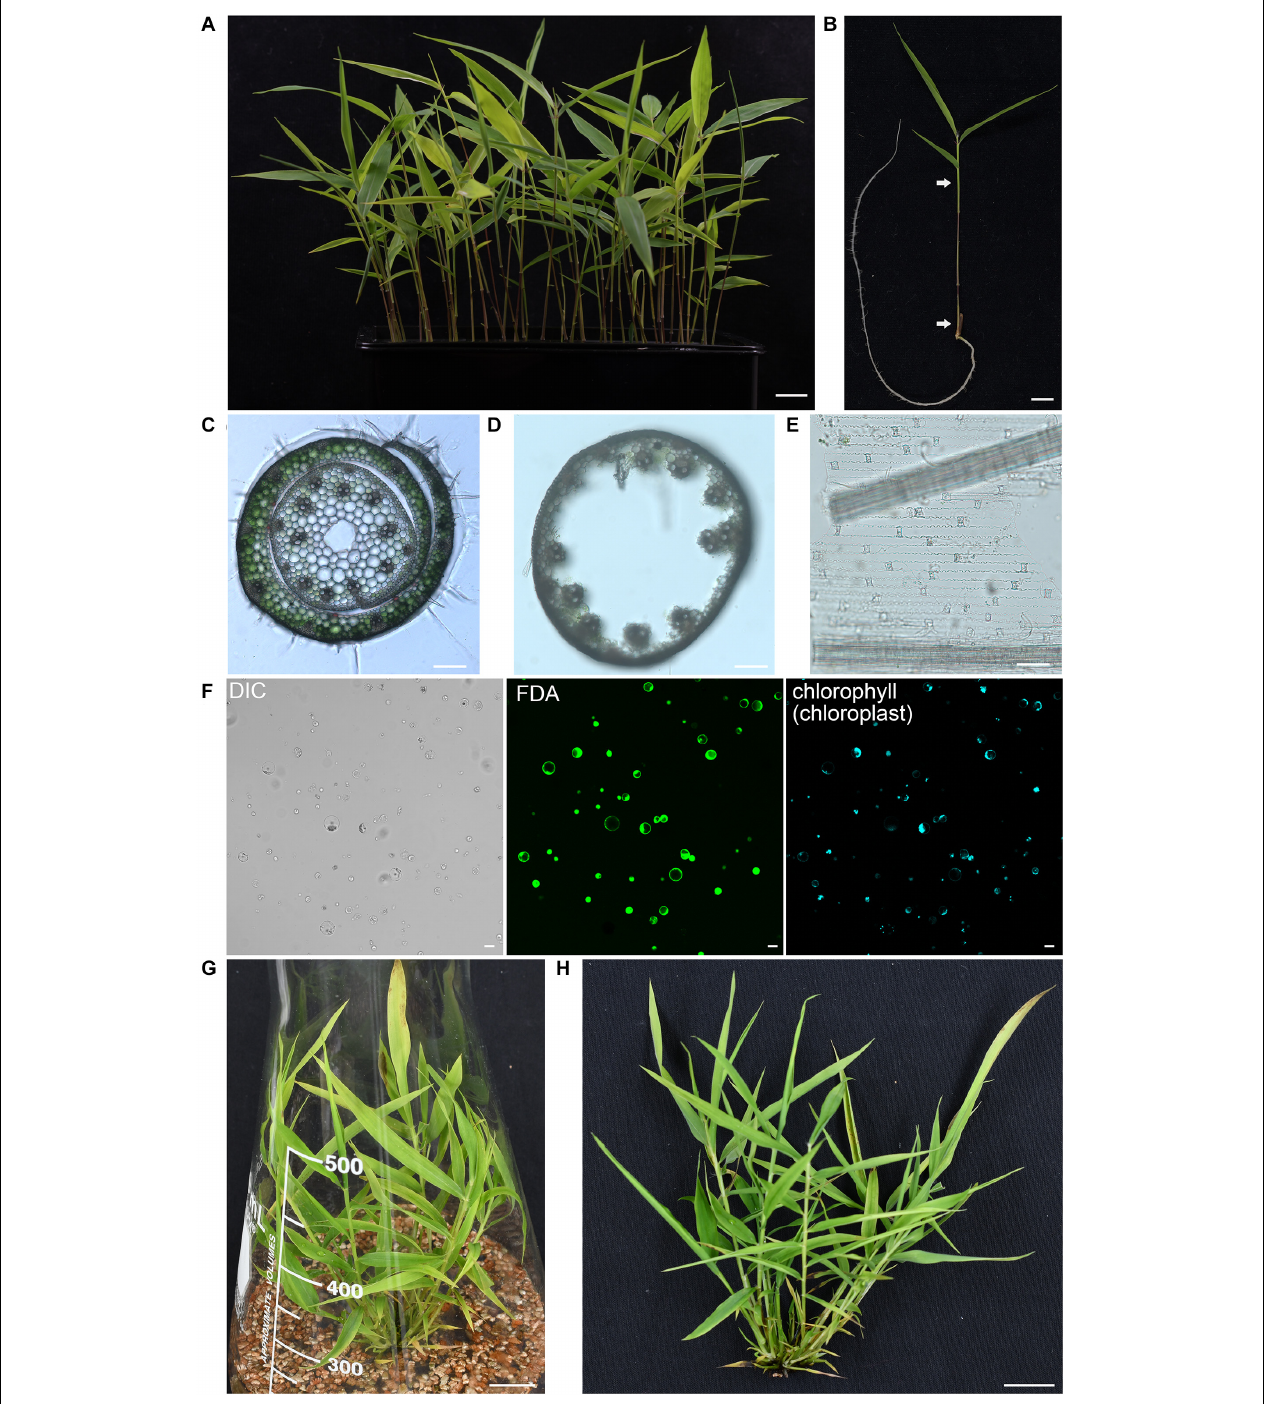
FIGURE 1 | Isolation of protoplasts from moso bamboo seedling. (A) Morphology of 5-week-old greenhouse-grown green moso bamboo seedling used for protoplast isolation. Scale bar = 1.5 cm. (B) The culm and leaf sheath between the two arrows were cut in cross section and enzymatically digested for protoplast isolation. Scale bar = 1.5 cm. (C) A cross-sectional microscopic view of an intact culm with leaf sheath before enzyme digestion from a 5-week-old moso bamboo seedling. Scale bar = 10 µ m. (D,E) Microscopic view of materials after enzyme digestion showing vascular bundles and epidermal cells in culm (D) or leaf sheath (E) remain, suggesting that protoplasts were mainly digested from cortical cells of culms and mesophyll cells of leaf sheaths. Scale bar = 10 µ m. (F) FDA staining of isolated protoplasts showing a high level of vitality. Protoplasts were incubated with FDA for 2 min and then observed under confocal. DIC, differential interference contrast. Scale bar = 25 µ m. (G,H) Morphology of 5-week-old micropropagated moso bamboo seedling (G) . The aerial part of seedlings (H) was used for protoplast isolation. Scale bar = 2 cm.